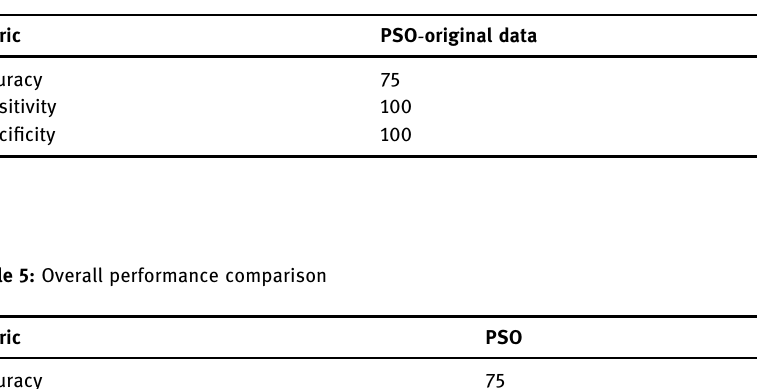
Table 4: Attribute selection comparison